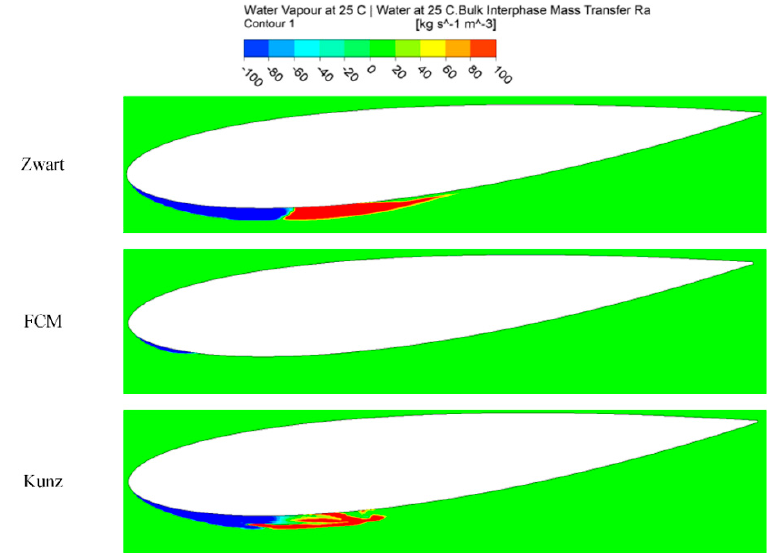
Figure 4. Interphase mass transfer rate distribution of different cavitation models ( σ = 1.075, α = 60°).